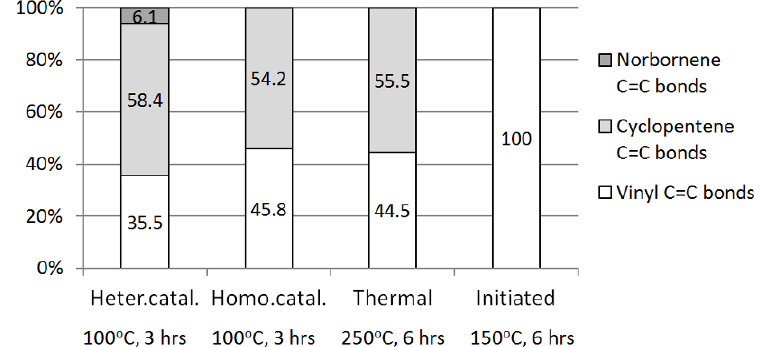
Figure 11. Contribution of double bonds of different types to the total unsaturation of the cooligomers synthesized by different methods.